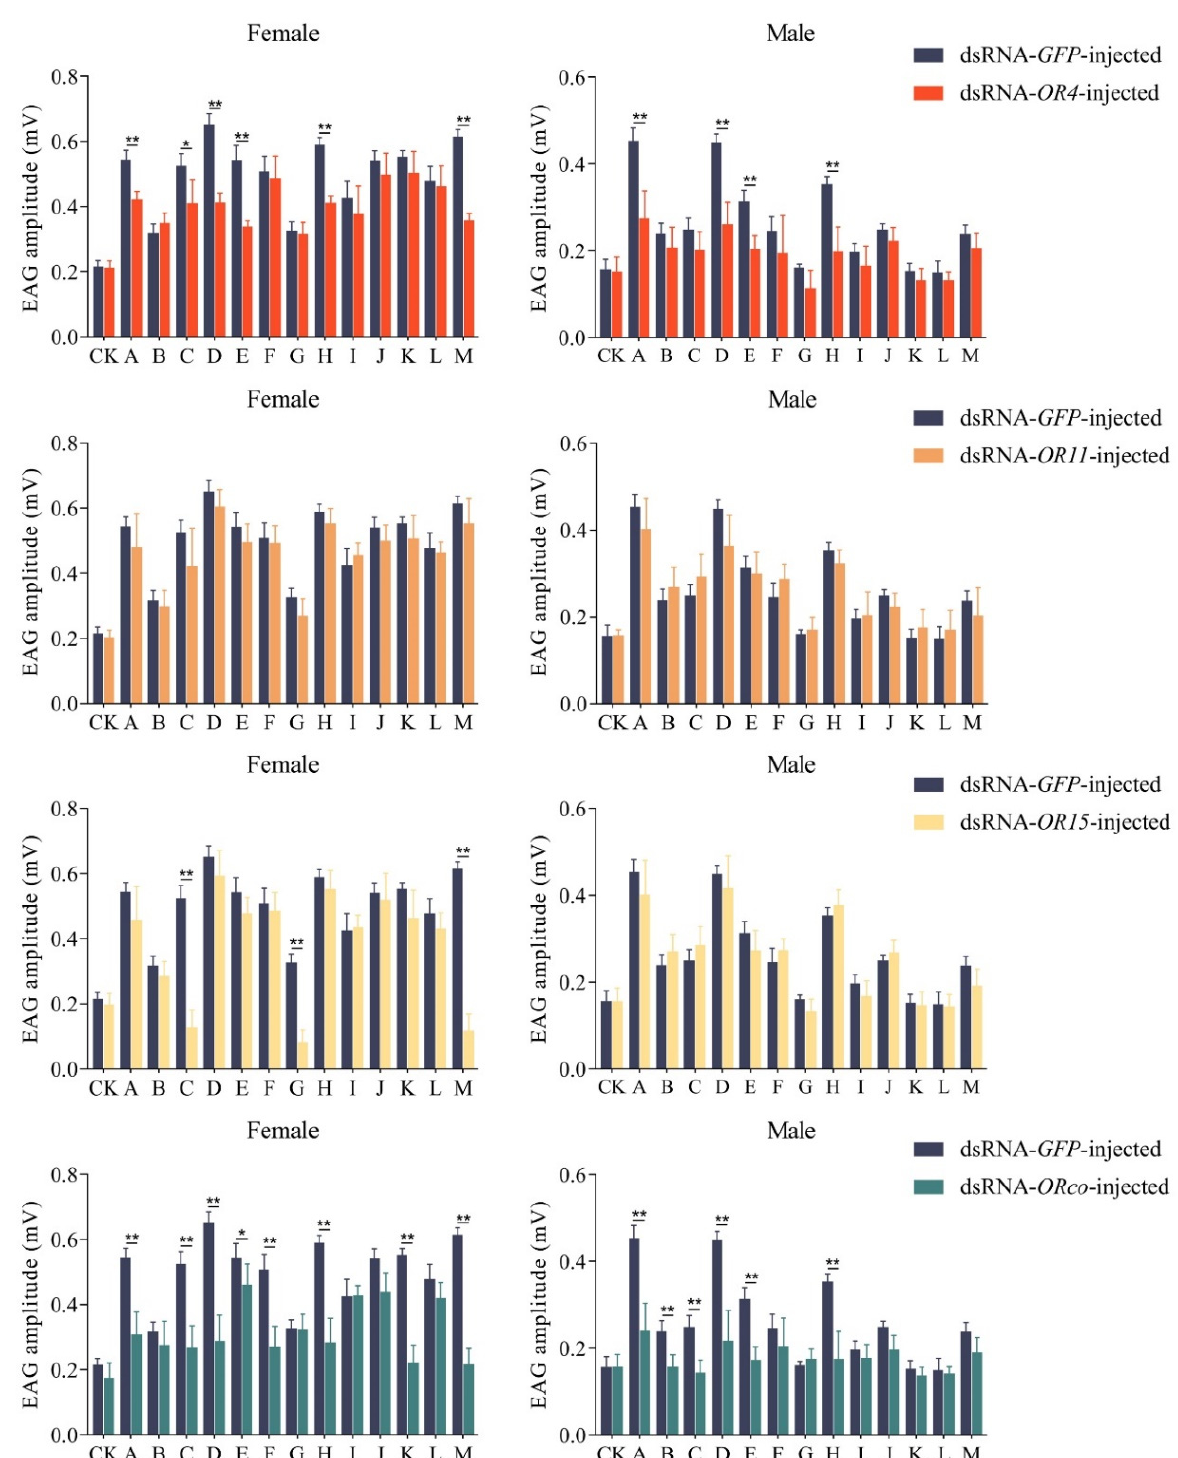
Figure 5. EAG responses of dsRNA- OR4 -injected, dsRNA- OR11 -injected, dsRNA- OR15 -injected and dsRNA- ORco -injected in G. daurica female and males to various compounds. Columns indicate the mean ± standard error of six independent experiments. ( T -test; *: p < 0.05; **: p < 0.01). CK: